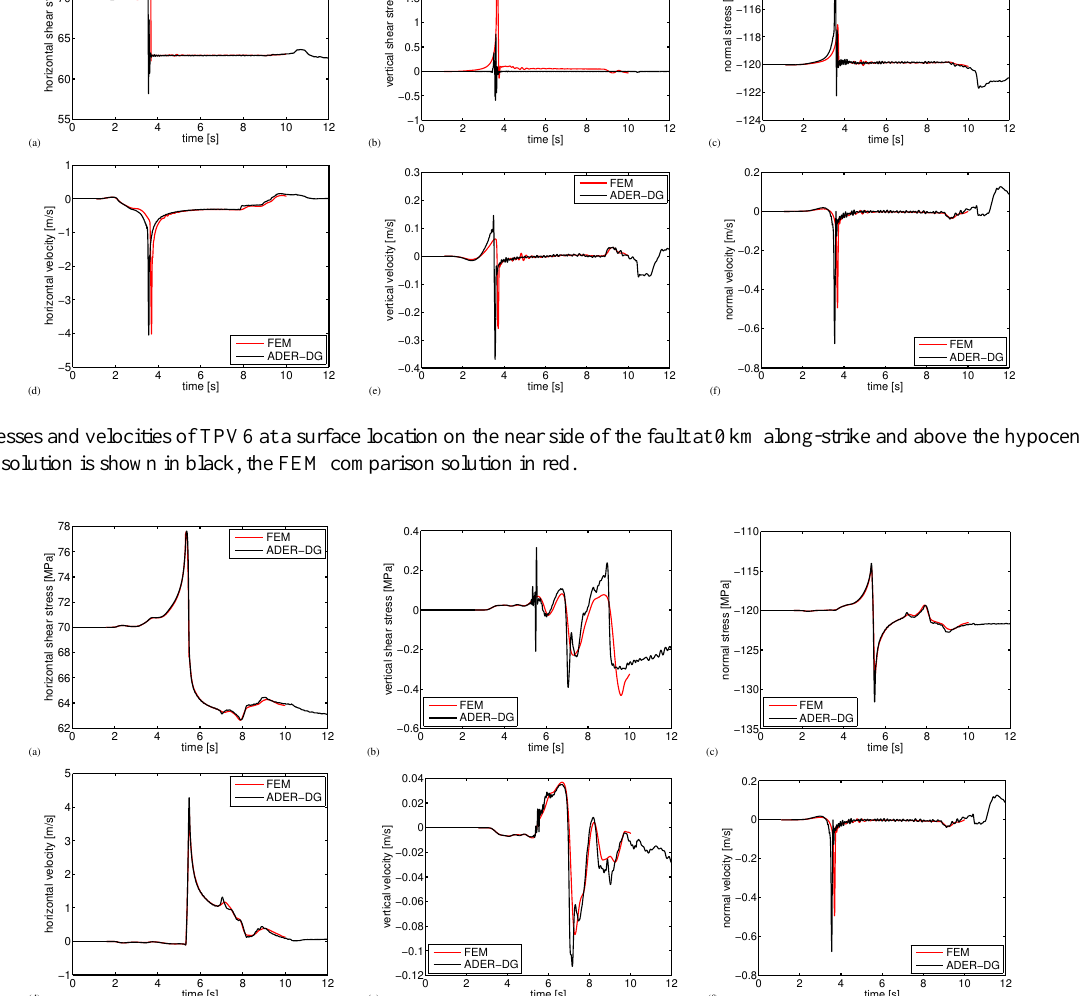
Fig. 14. Stresses and velocities of TPV6 at a location on the far side of the fault at − 12 km along-strike and 7 . 5km depth, which corresponds